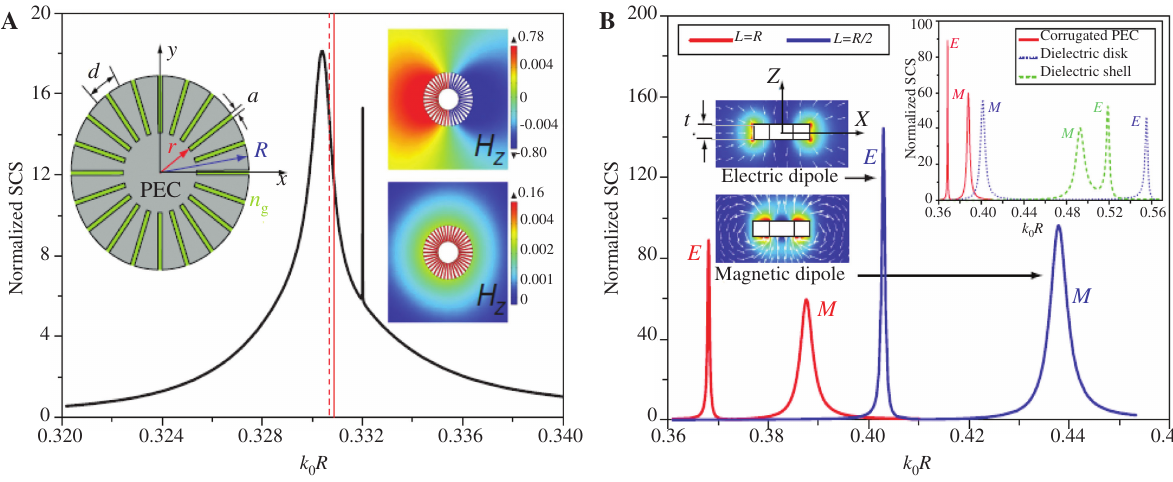
Figure 25: Magnetic LSPs in subwavelength metallic disk corrugated with dielectric grooves. (A) SCS for a 2D disk with r = 0.4 R , N = 40, = 8. The low-energy peak ( k a / d = 0.3, and n R = 0.33) denotes two resonances: the electrical and magnetic dipoles, whose magnetic field g 0 amplitudes ( H ) are shown in the upper and lower insets, respectively. The solid (dashed) vertical lines represent the position of the electric z (magnetic) resonance obtained from the analytical model. (B) Textured metallic disk with finite thickness. The red and blue lines correspond to SCS for corrugated disks with thickness t = R and t = R /2, respectively. Top (and bottom) left insets: Near-field distribution of the electric field (and magnetic) dipole resonances for a disk of thickness t = R /2. The arrows show the electric (magnetic) field lines, and the color map shows the norm of electric (magnetic) field. Reproduced from [48] with permission.